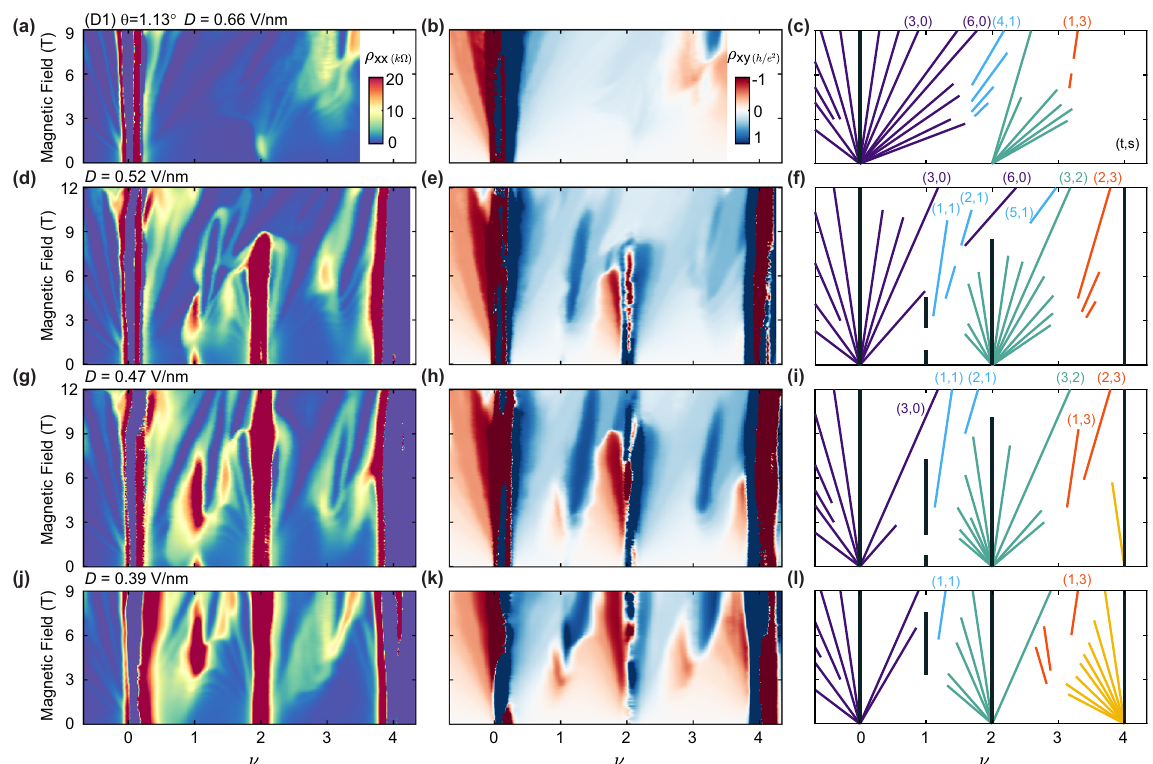
Fig. 3 Landau fan diagrams and spontaneous fl avor polarization at the high fi eld for D > 0. Landau fan diagrams in device D1 at ( a , c ) D = 0.66 V/nm, ( d , f ) D = 0.52 V/nm, ( g , i ) D = 0.47V/nm, and ( j , l ) D = 0.39 V/nm, all acquired below T = 0.3 K. The leftmost column shows ρ xx , the central column shows ρ xy , and the rightmost column schematically denotes the strongest observed gapped states. In the schematic, purple lines correspond to states tracing to ν = 0, blue to ν = 1, green to ν = 2, orange to ν = 3, and yellow to ν = 4. The vertical black lines denote topologically trivial insulating states. Selected states are labeled by their respective ( t , s )